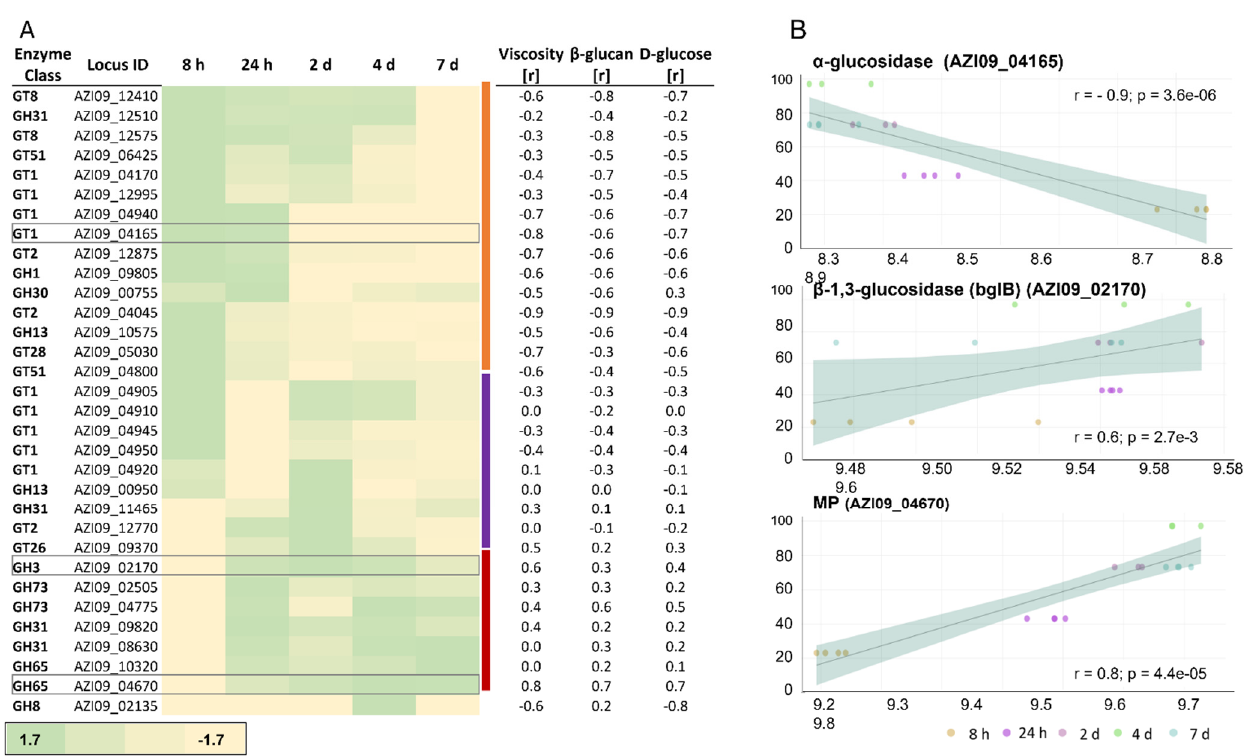
Figure 6. Expression of GHs and GTs in the cell lysate. ( A ) Heat map of the expressed enzymes over time. The three clusters of proteins are indicated by the color bar on the right (orange, purple, and red). Relative fold change of protein expression compared to the mean depicted by color intensity, as stated below the figure (a range between -1.7-fold and 1.7-fold). Correlation coefficient values with viscosity, β -glucan, and D-glucose are listed next to the specific GHs and GTs. ( B ) The correlation of the expression of α -glucosidase AZI09_04165, β -1,3-glucosidase (bglB) AZI09_02170, and the MP AZI09_04670 with viscosity, including correlation coefficient values (r) and p -values ( p ).